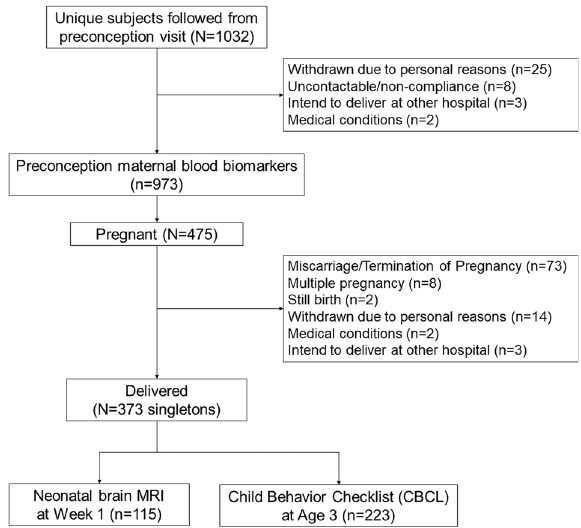
Fig. 1 Flowchart for study samples from the Singapore Precon- ception Study of Long-Term Maternal and Child Outcomes (S- PRESTO) prospective study. Each box in the fl owchart indicates the sample sizes for data collected at various time points and the number of participants being